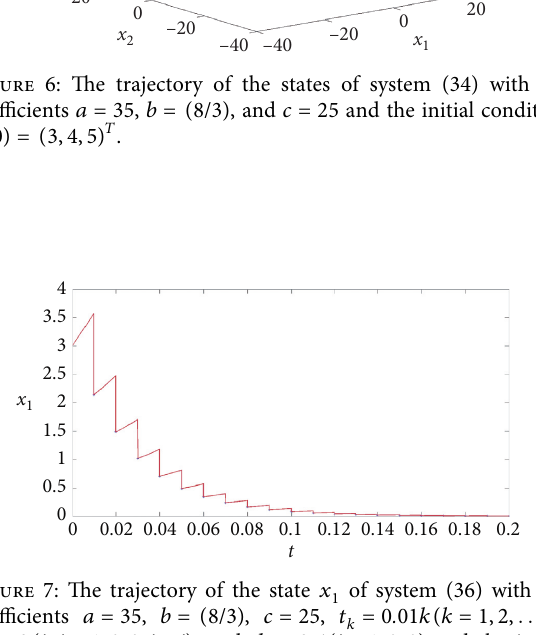
of system (36) with the 3 � 0 . 6 ( i � 1 , 2 , 3 ) and the initial ii